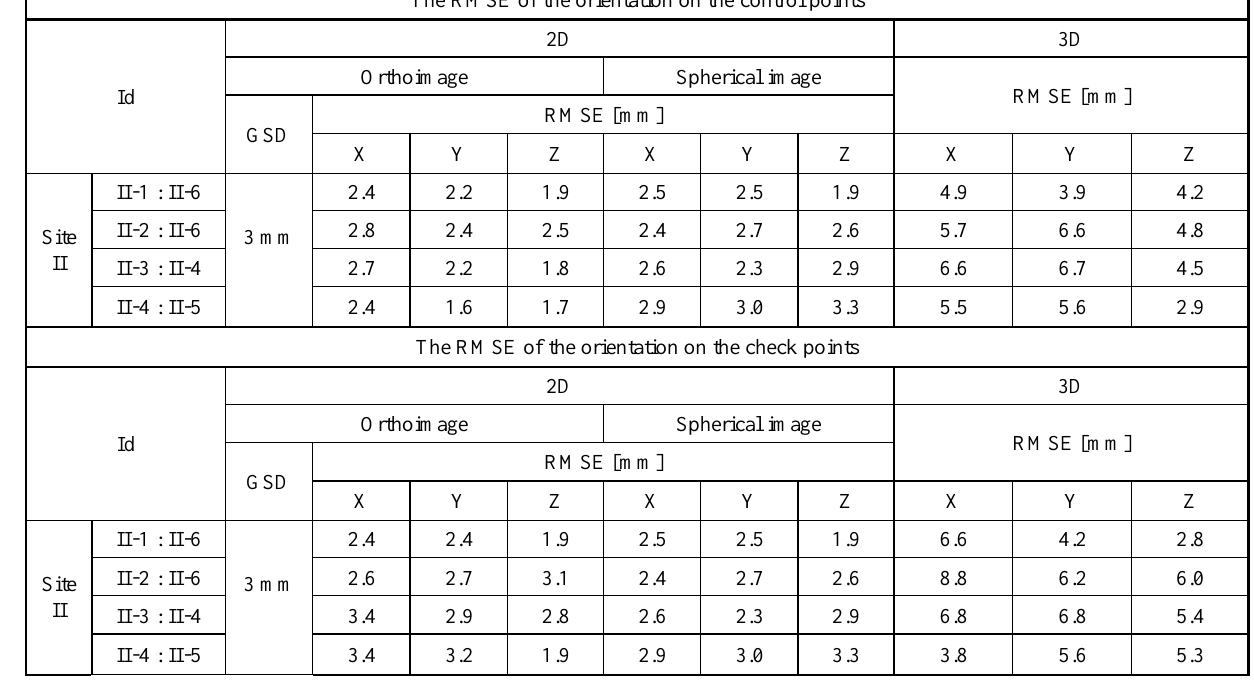
Table 3. RMSE of the point clouds orientation on the control and check points – Test site